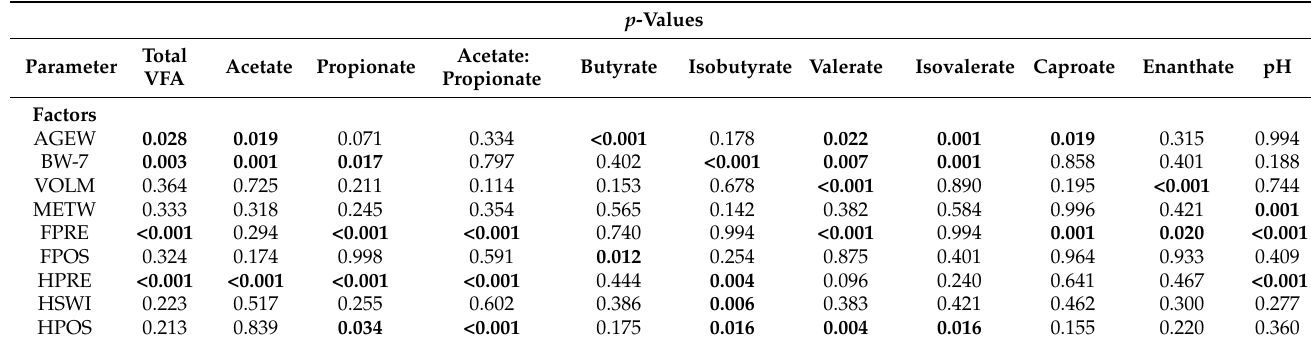
Table 4. Effect of factors examined on the concentration of ruminal volatile fatty acids (VFA) and pH values (factor with a significant effect in bold) determined in 243 Holstein dairy calves of eight commercial dairy farms at 3 different time-points ( − 7 d: 7 days pre-weaning, at 0 d: weaning, and 7 d: 7 days